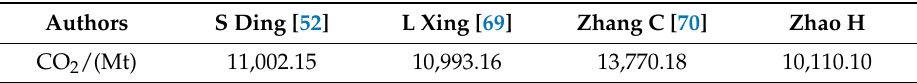
Table 5. Forecasting values of CO 2 emissions of China in 2020 by different